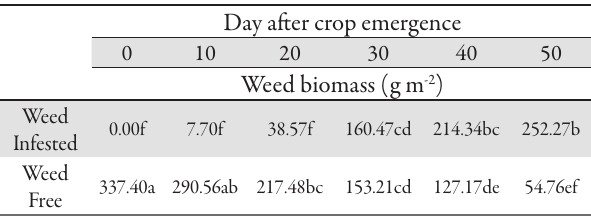
Tab. 1. Means comparison for weed biomass at different treatments of weed interference and weed free periods using LSD test